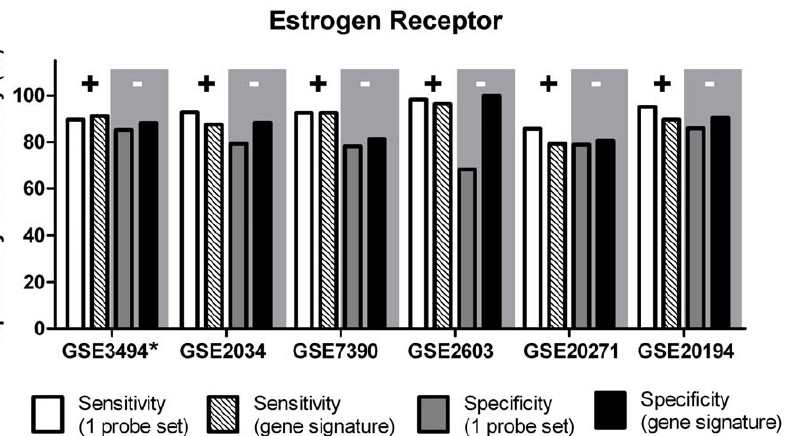
Figure 2. ER status determination: sensitivity (‘ + ’) and specificity (‘-’) obtained with two different microarray-based methods. The improved feature is highlighted by gray background. * Training